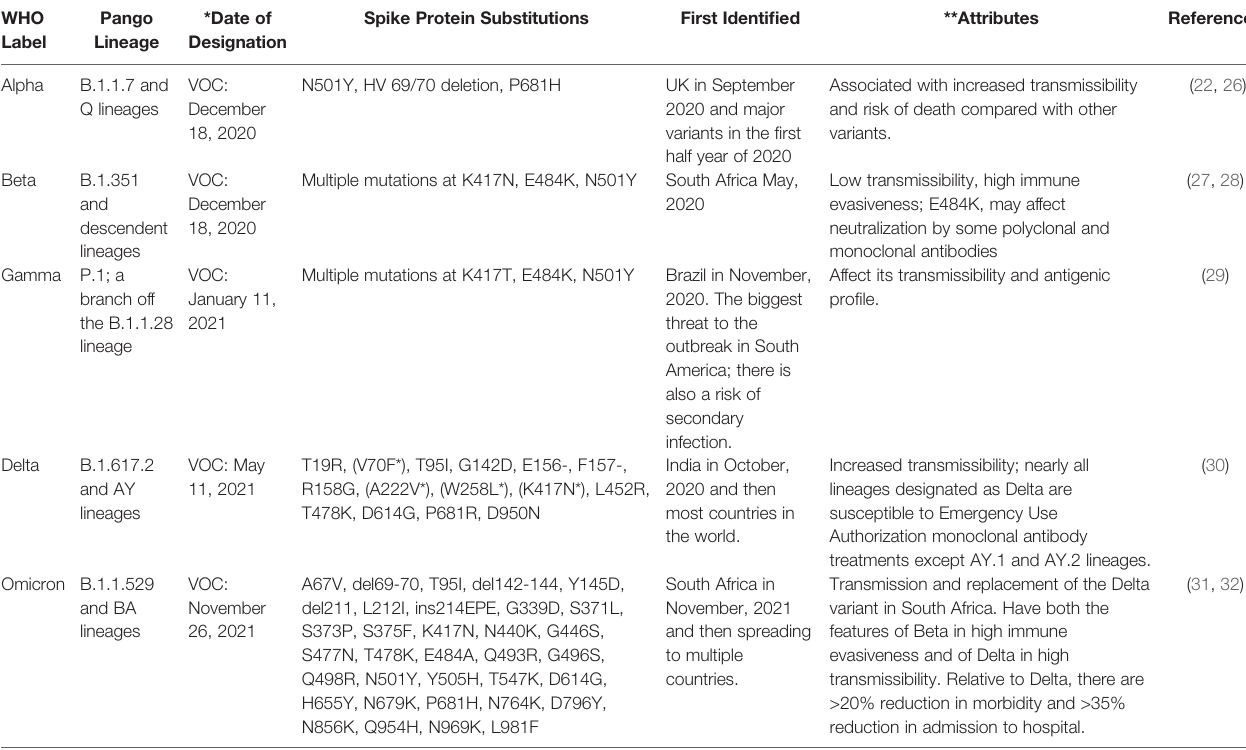
TABLE 1 | SARS-CoV-2 variants classi fi cation and